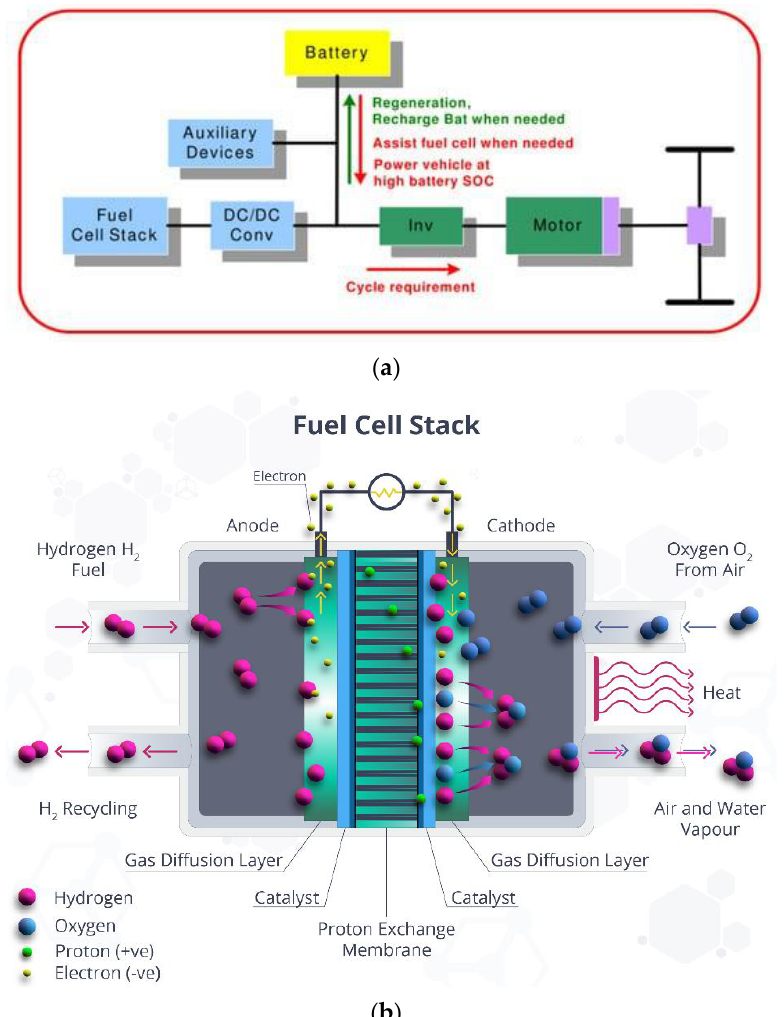
Figure 2. ( a ) Schematic of FC-based electric vehicle [29]. ( b ) The process of charging the cell with